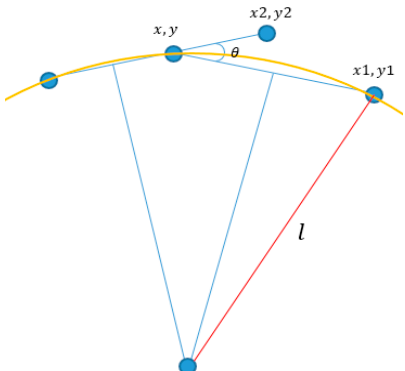
Figure 1. Calculation of angle of rotation and turning radius.